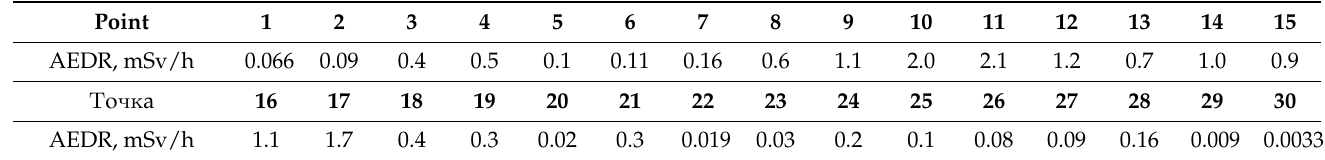
Table 2. Values of the ambient radiation dose equivalent rate at the points of equipment room No. 2.